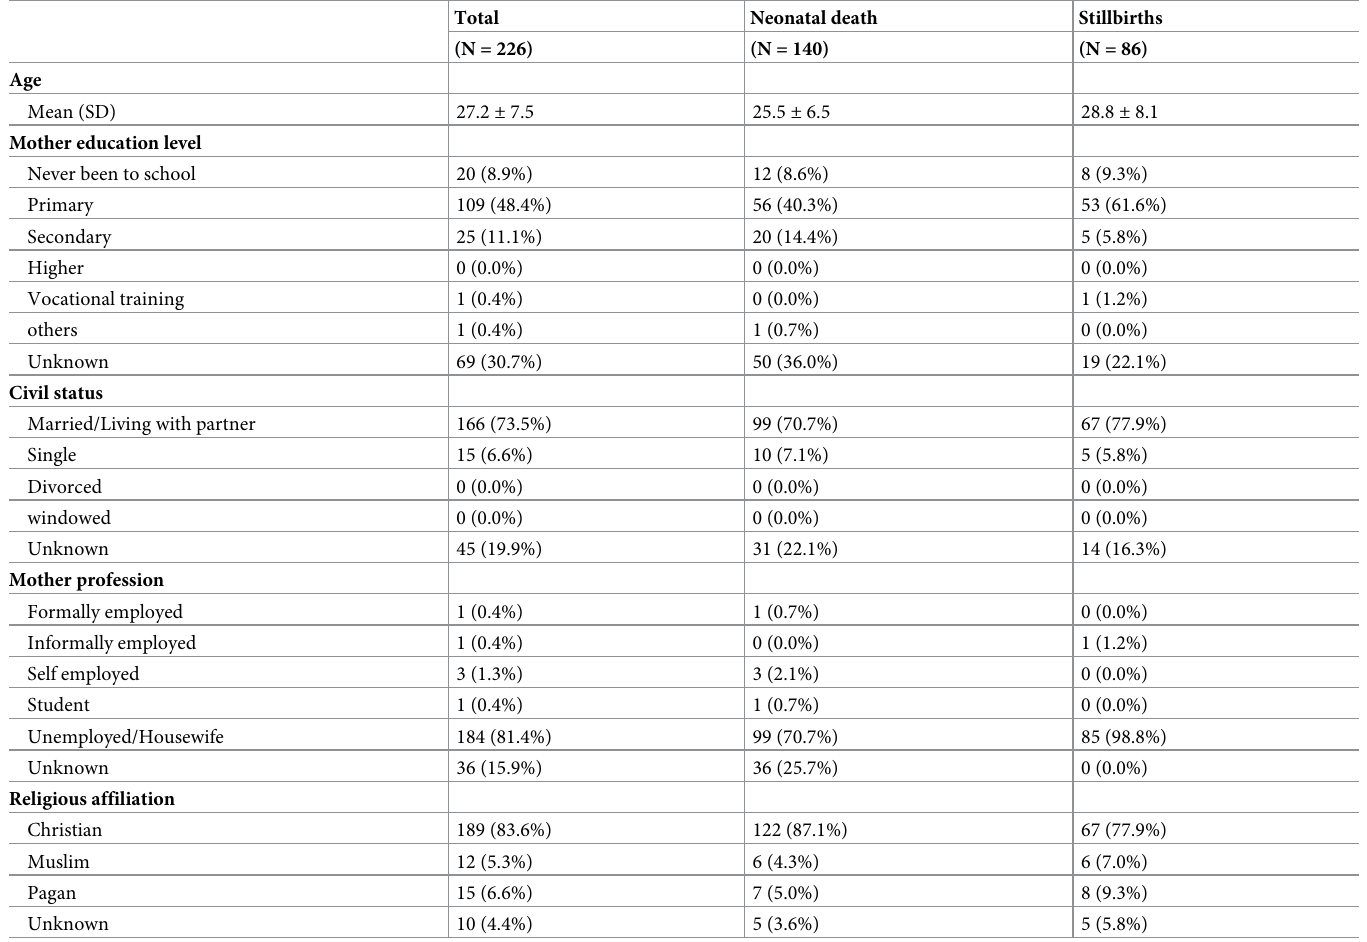
Table 1. Socio-demographic characteristics of women who encountered perinatal